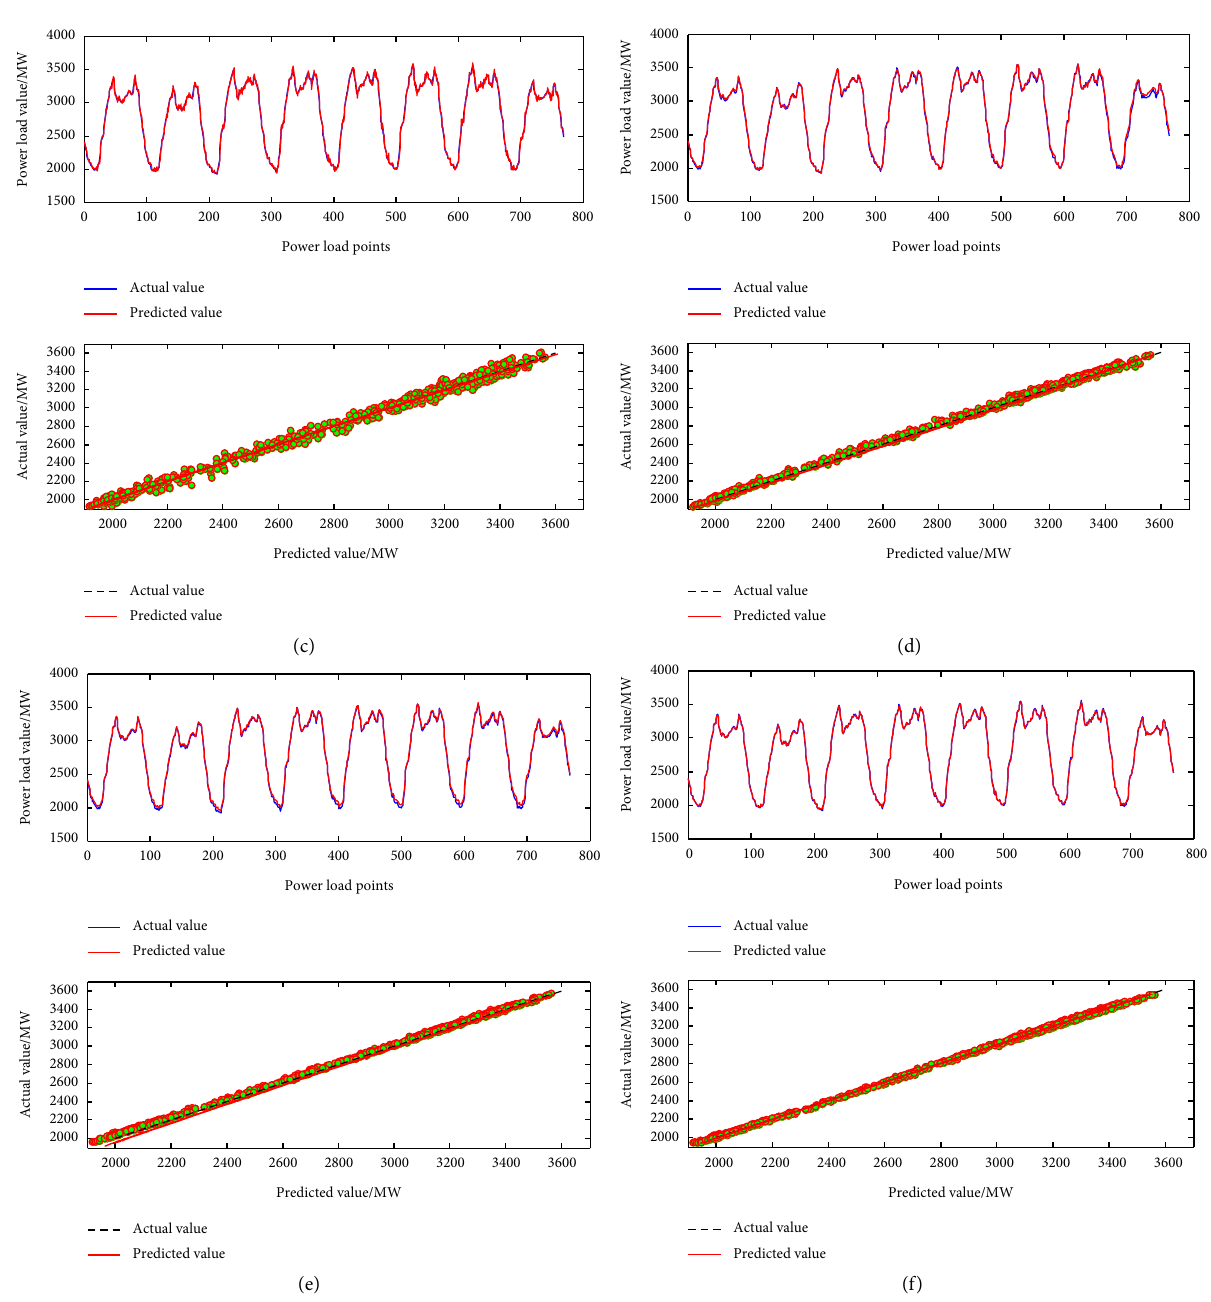
Figure 11: The results of each prediction model. Prediction results of (a) ARMA, (b) BPNN, (c) LS-SVM, (d) EMD, (e) EEMD, and (f) VMD.